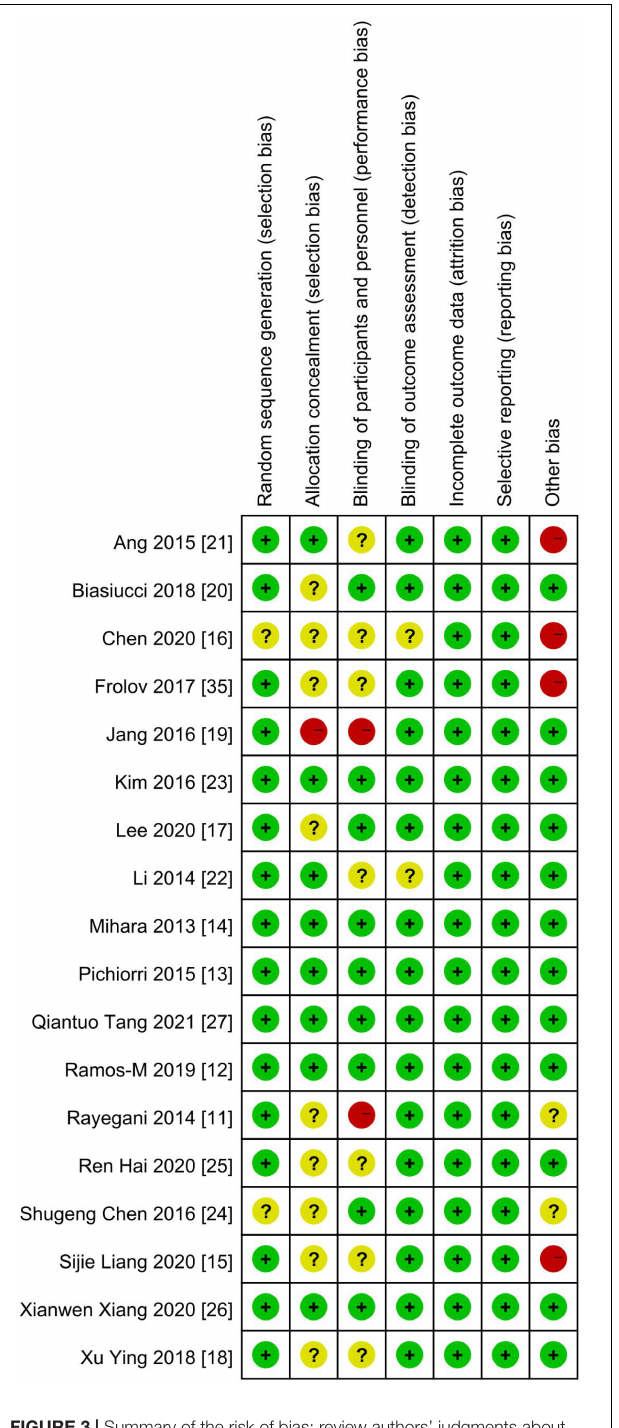
meaning that the average FMA-UE score of the experimental group is separated by 89% of the pooled SD from the control group. But the result had a high heterogeneity ( I 2 =